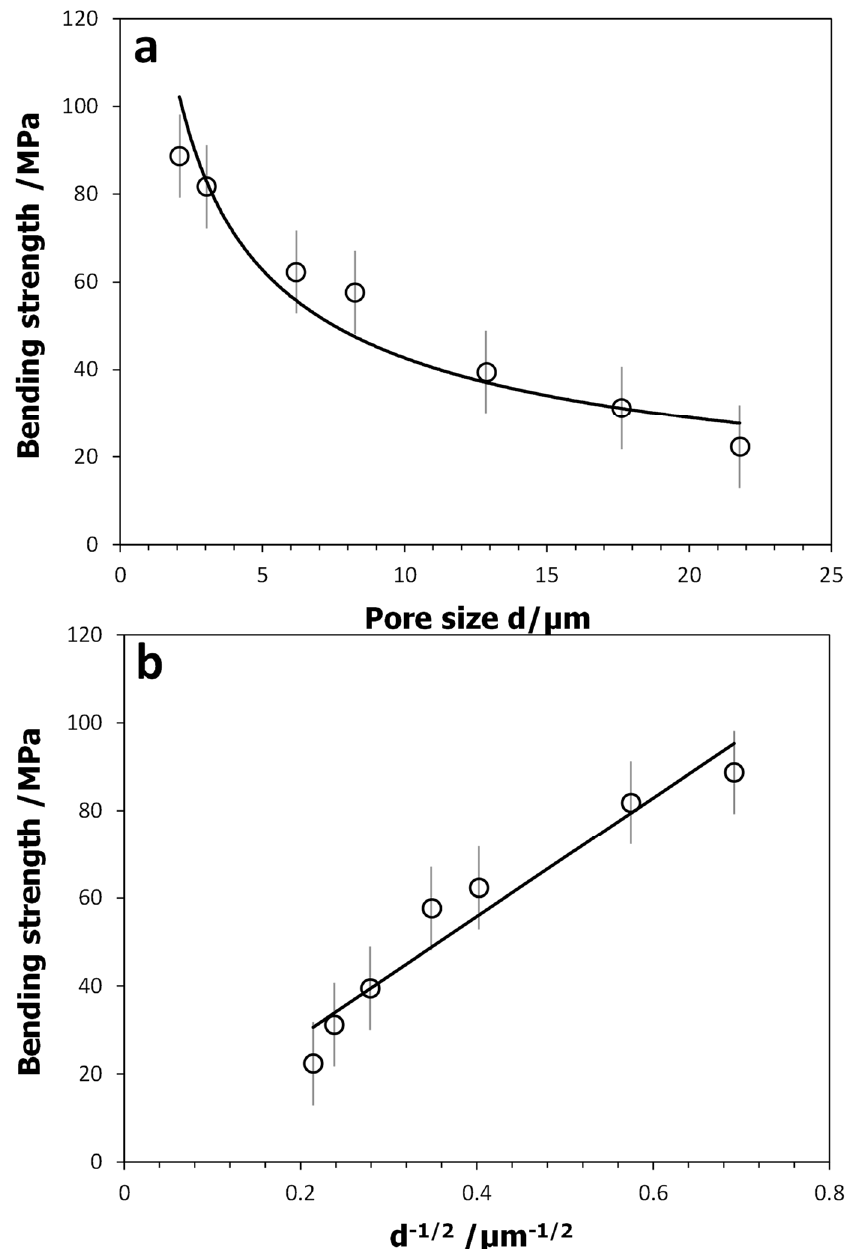
Figure 5. Relationship curves between the bending strength and the average pore size d ( a ) and d − 1/2 ( b ) for porous Ti 3 SiC 2 .